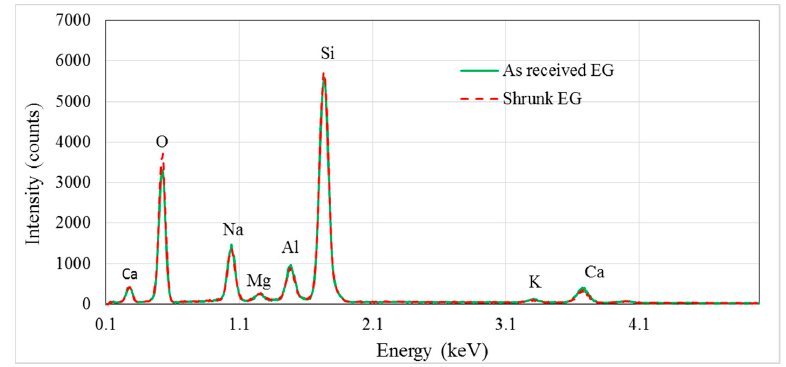
Figure 2. EDS spectra of raw and shrunk EG particles.